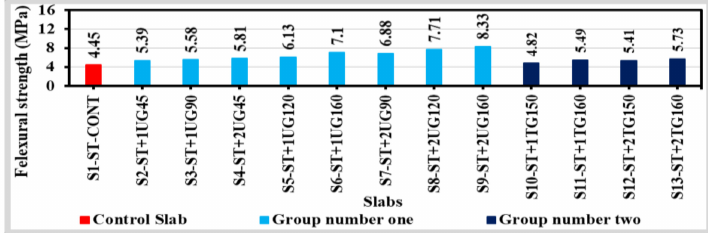
Figure 11. The concrete slabs load at di ff erent critical points in comparison to the concrete control slab.